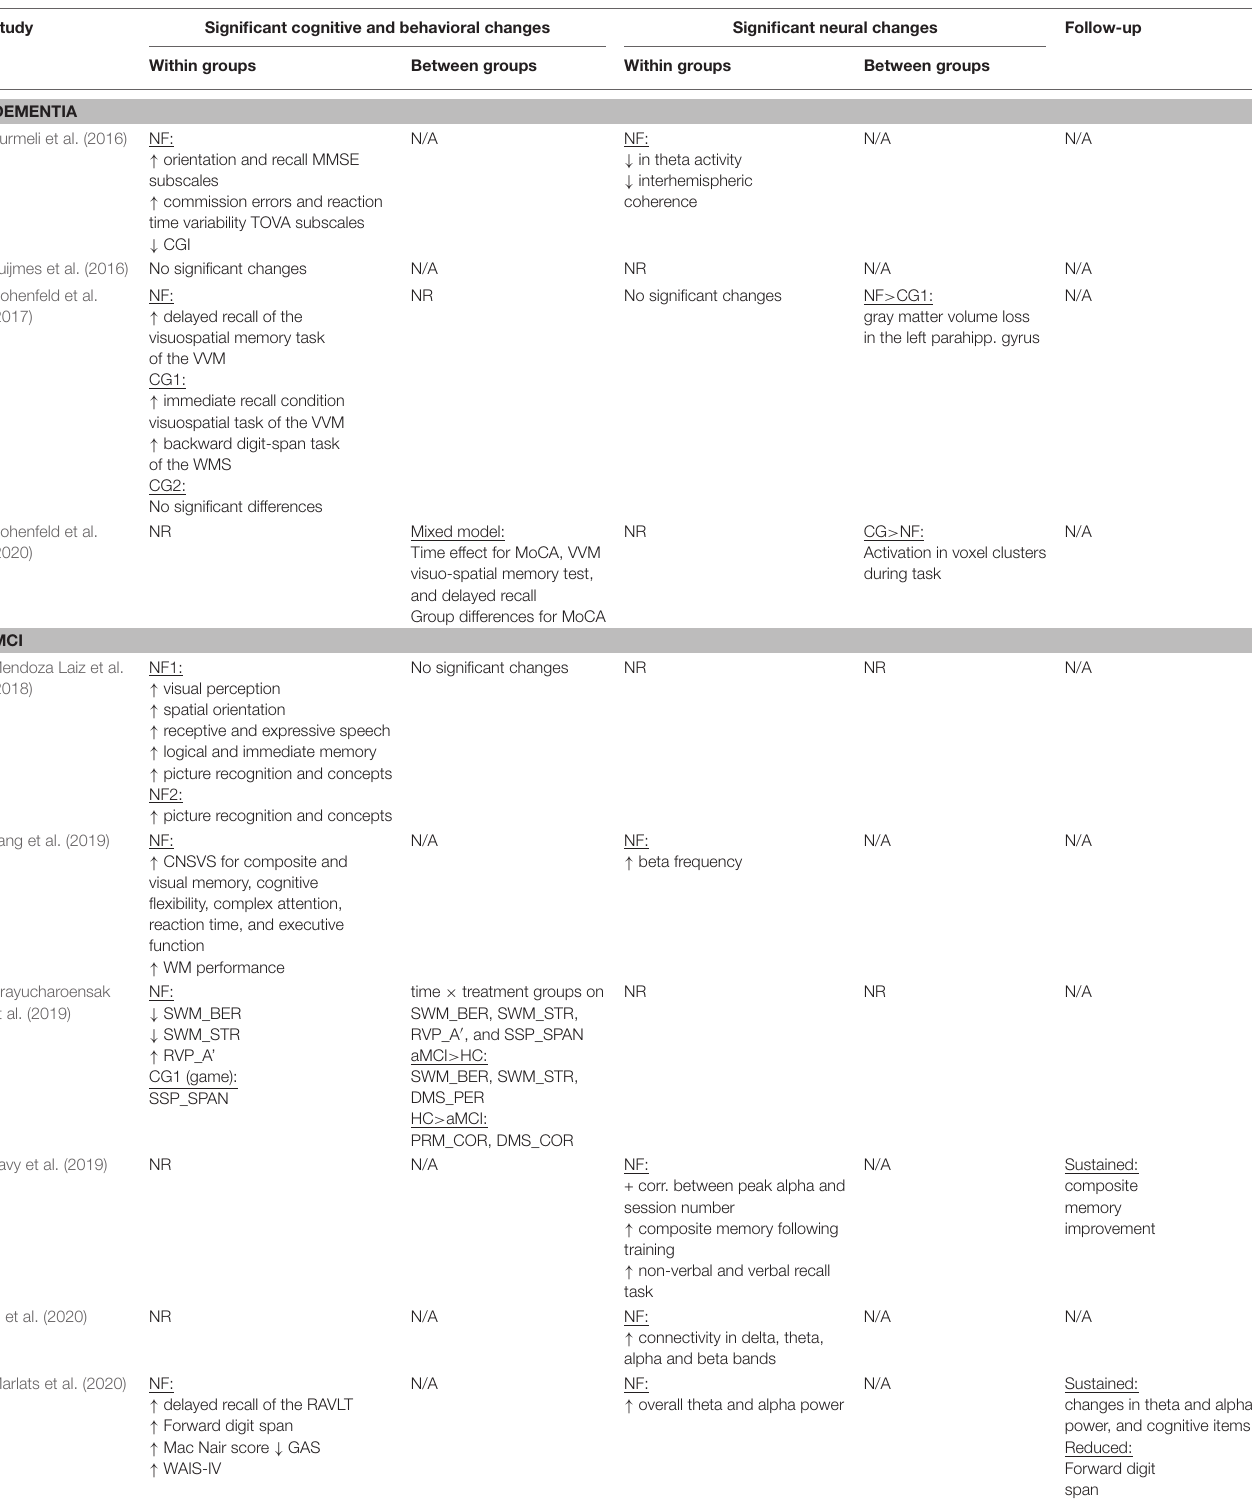
TABLE 6 | Summary of cognitive, behavioral, and neural outcomes. Study Significant cognitive and behavioral changes Significant neural changes Follow-up Within groups Between groups Within groups Between groups